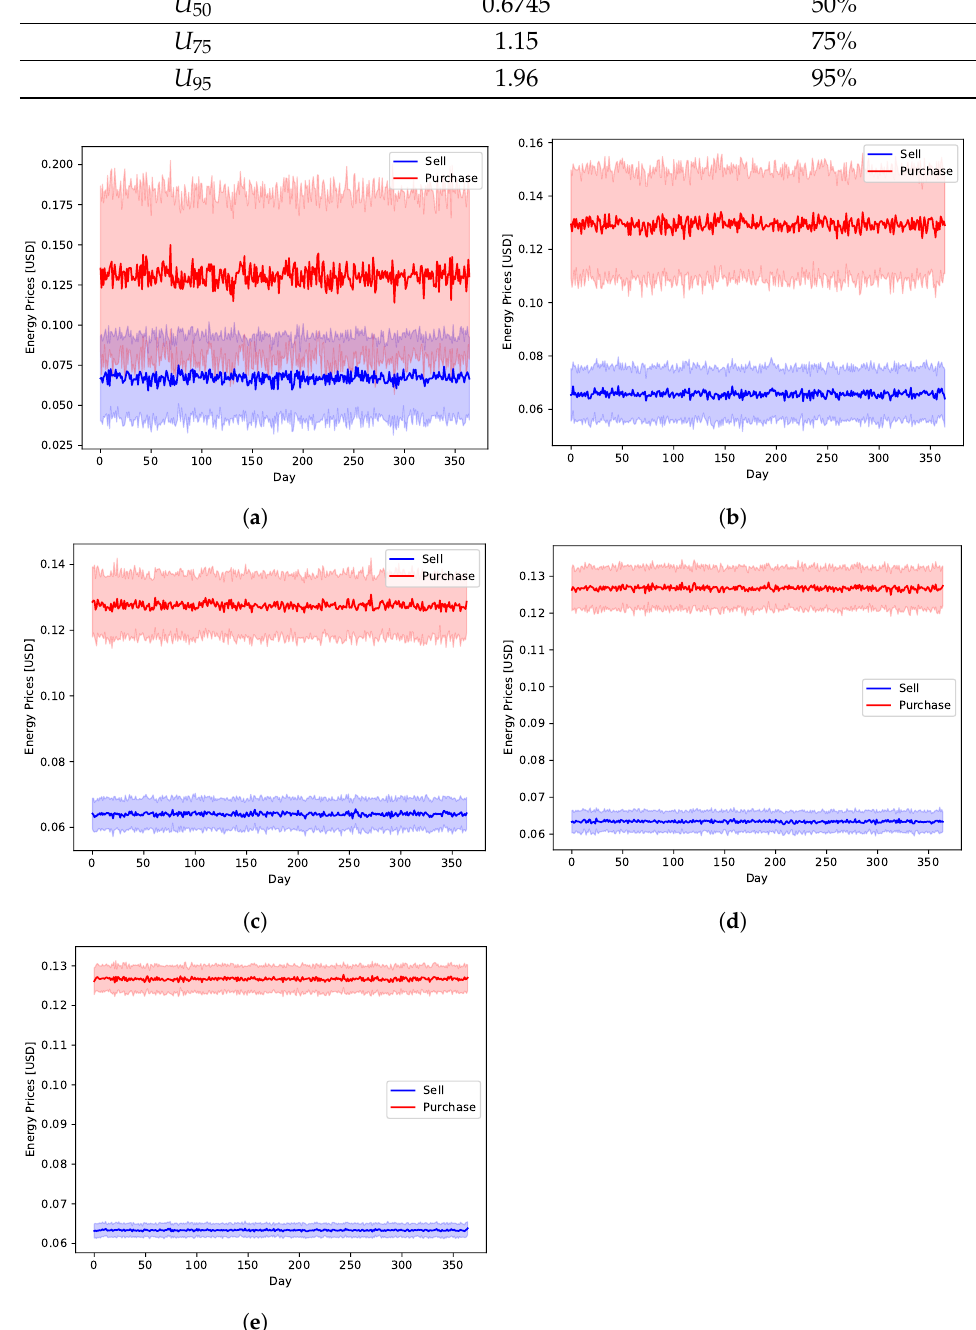
Figure 6. The simulated energy sell and purchase prices to and from the public network with different global uncertainty levels. ( a ) U 10 , ( b ) U 25 , ( c ) U 50 , ( d ) U 75 , ( e ) U 95